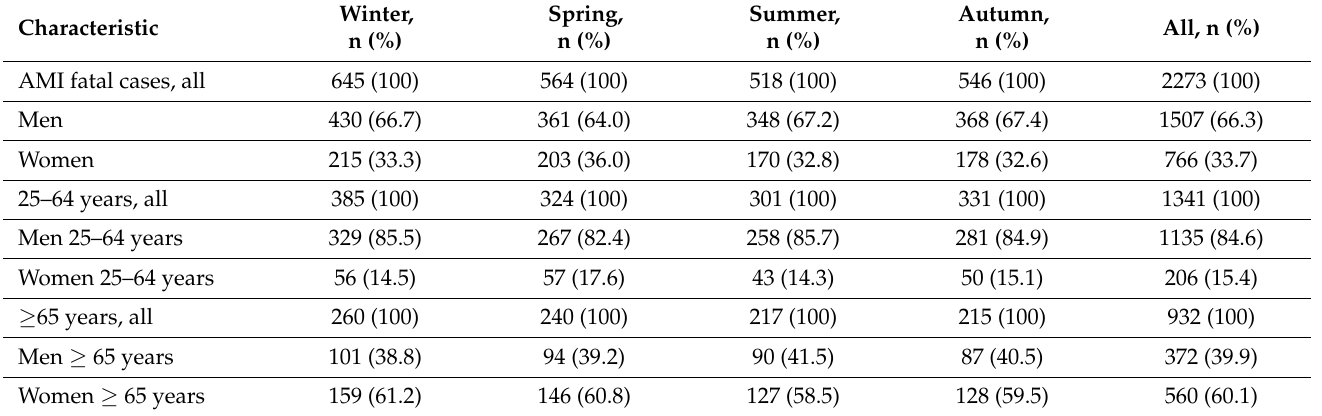
Table 1. Characteristics of the study population of all fatal AMI cases in Kaunas during the study years 2006–2015, by age, sex, and